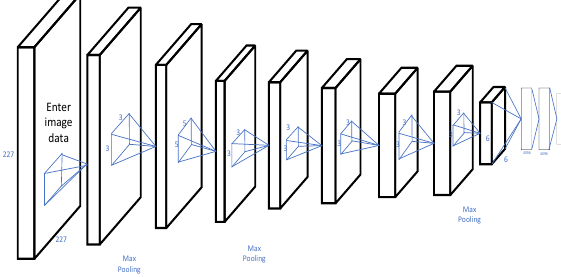
Figure 5 . Caffe Net sonar image feature model structure